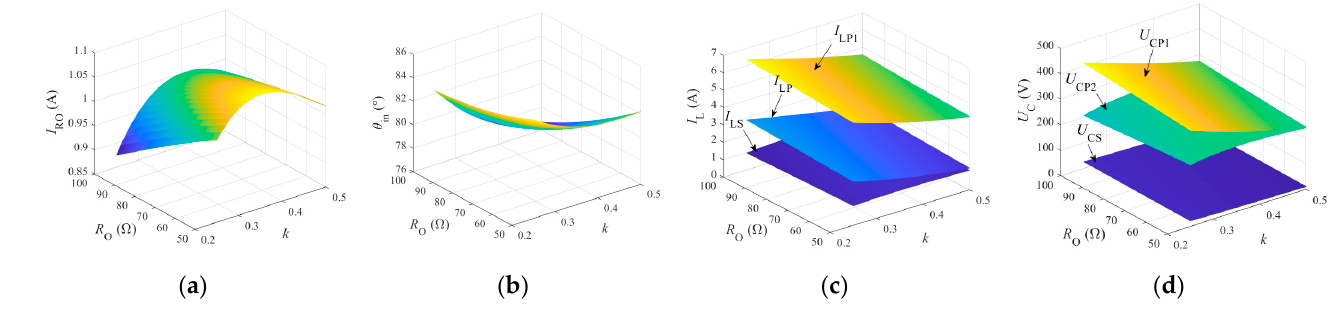
Figure 6. Main electrical values of CCO-type IPT system in case A: ( a ) output current; ( b ) input impedance angle; ( c ) current stresses on inductor and coils; ( d ) voltage stresses over capacitors.